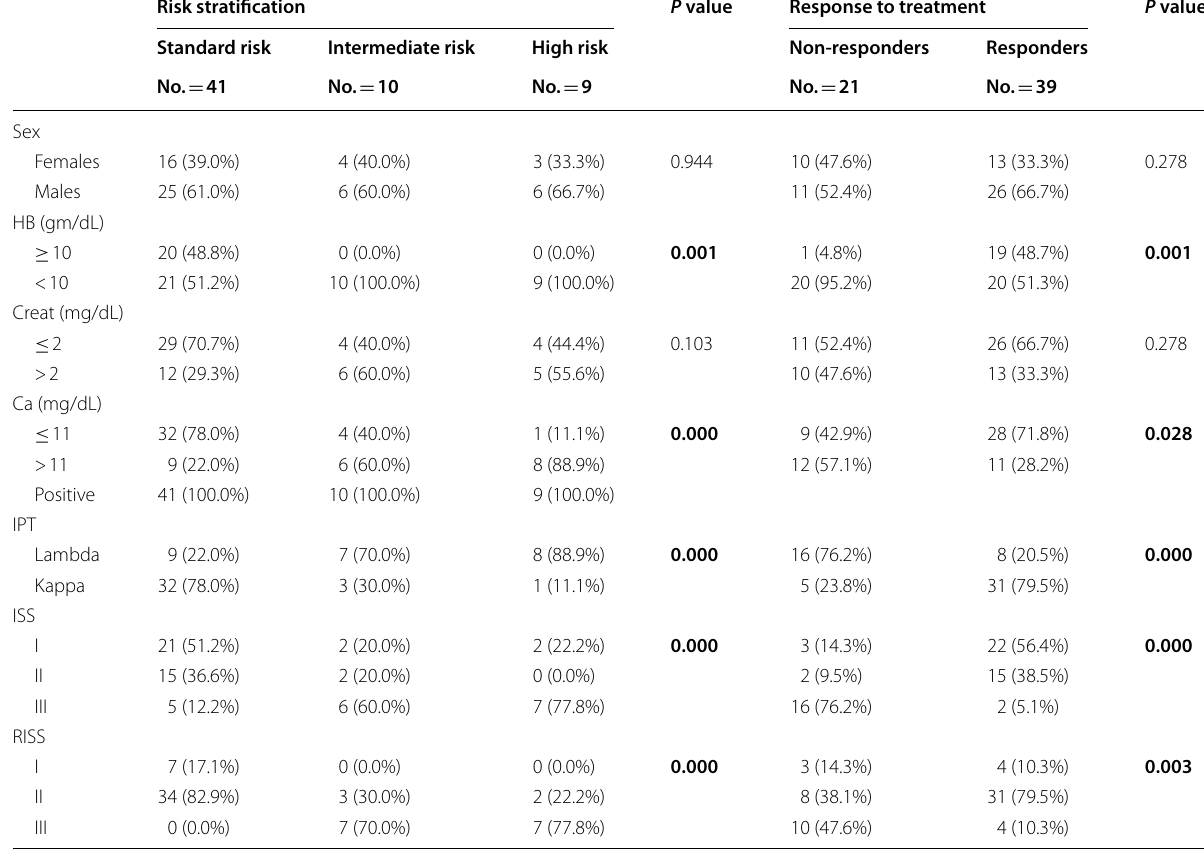
Table 2 Association between risk stratification and response to treatment with the studied parameters